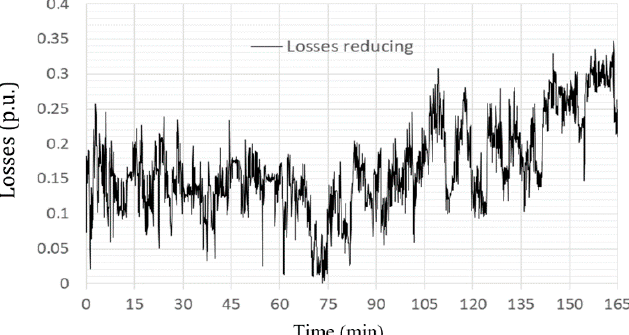
Figure 26. Evolution of the relative decrease of electrical losses upstream of the connection point, during the recordings (p.u.).